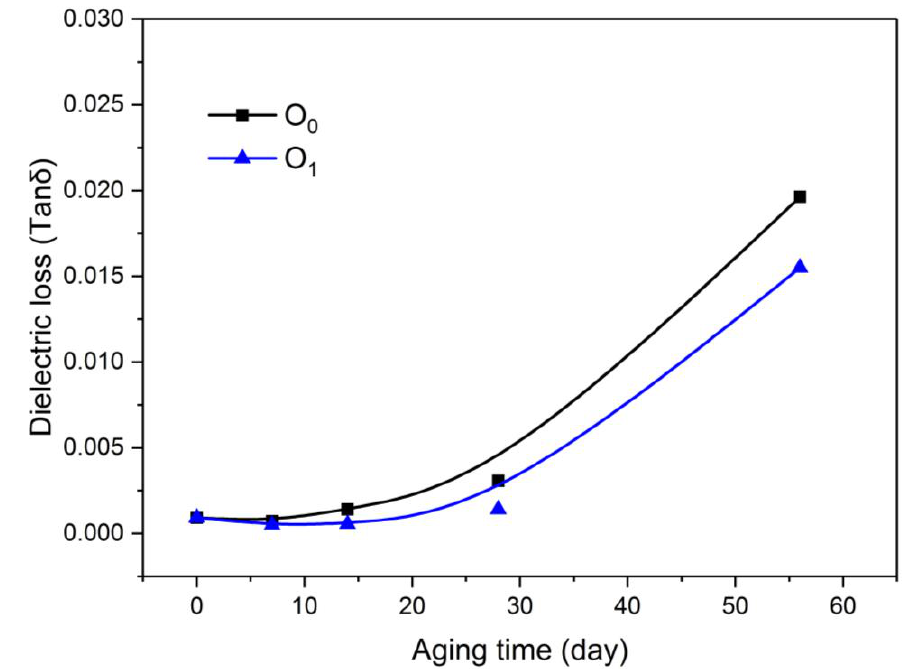
Figure 8. Variation of oil dielectric loss with aging process.